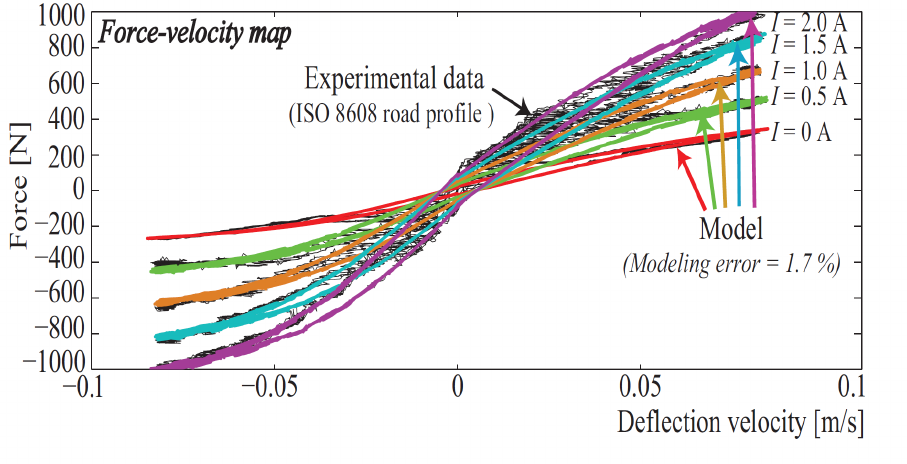
Figure 3. Magneto-rheological damper force–deflection velocity characteristic